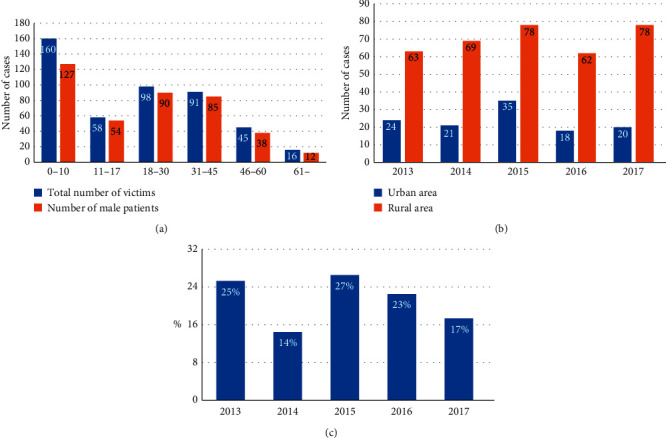
Age, sex, and regional distribution of patients (a, b) and proportion of firework-related eye injuries that occurred during spring festival (c). (a) The average age of the patients was 24 ± 18 years, 87% of patients were male, and 27% of patients were boys who were under 10 years old. (b) There was an average of 24 ± 7 patients from urban areas and 70 ± 8 patients from rural areas, per year between 2013 and 2017 (P < 0.05, t-test). (c) From 2013 to 2017, 21 ± 5% cases occurred during the Spring Festival, which was much higher than the average monthly incidence of 7.8%.